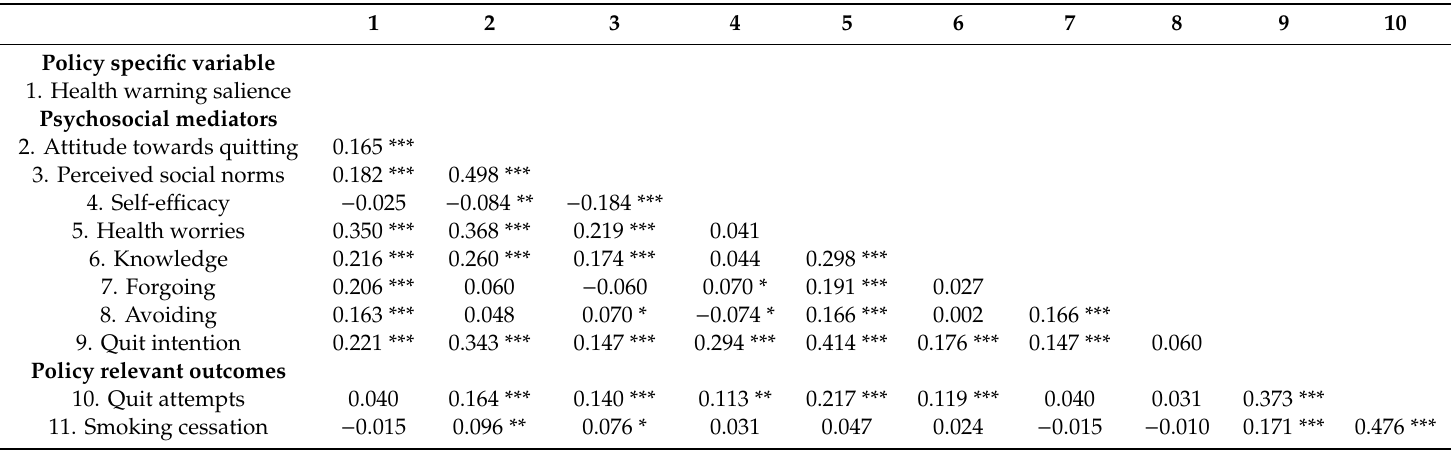
Table 3. Spearman correlations between the policy-specific variables, psychosocial mediators, and policy-relevant outcomes, weighted by gender and age.